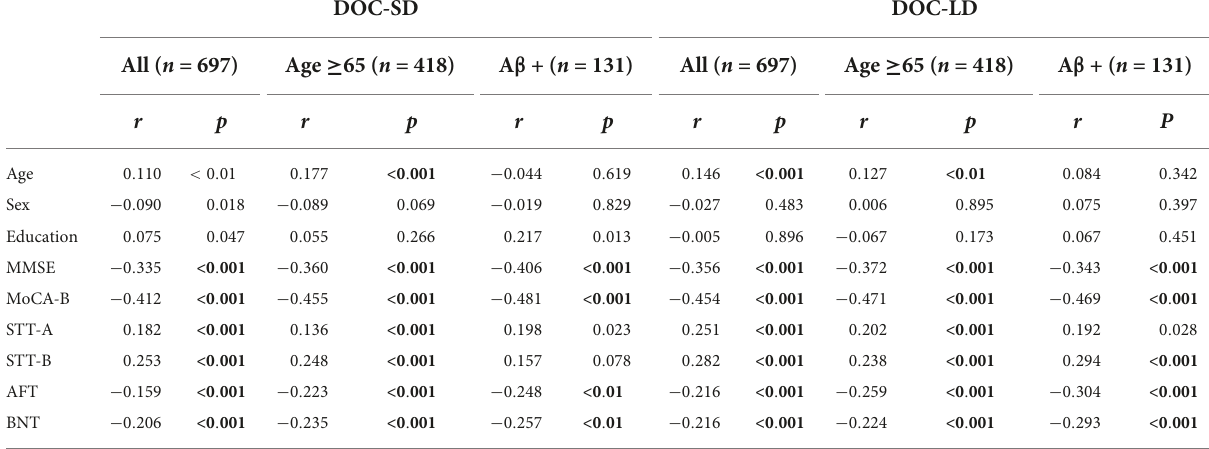
TABLE 2 Spearman correlation of relationship between metamemory scores and age, sex, education years, and neuropsychology test*. DOC-SD